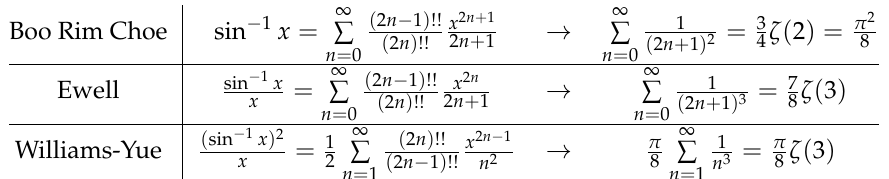
Table 1. Summary of Boo Rim Choe, Ewell and Williams-Yue’s